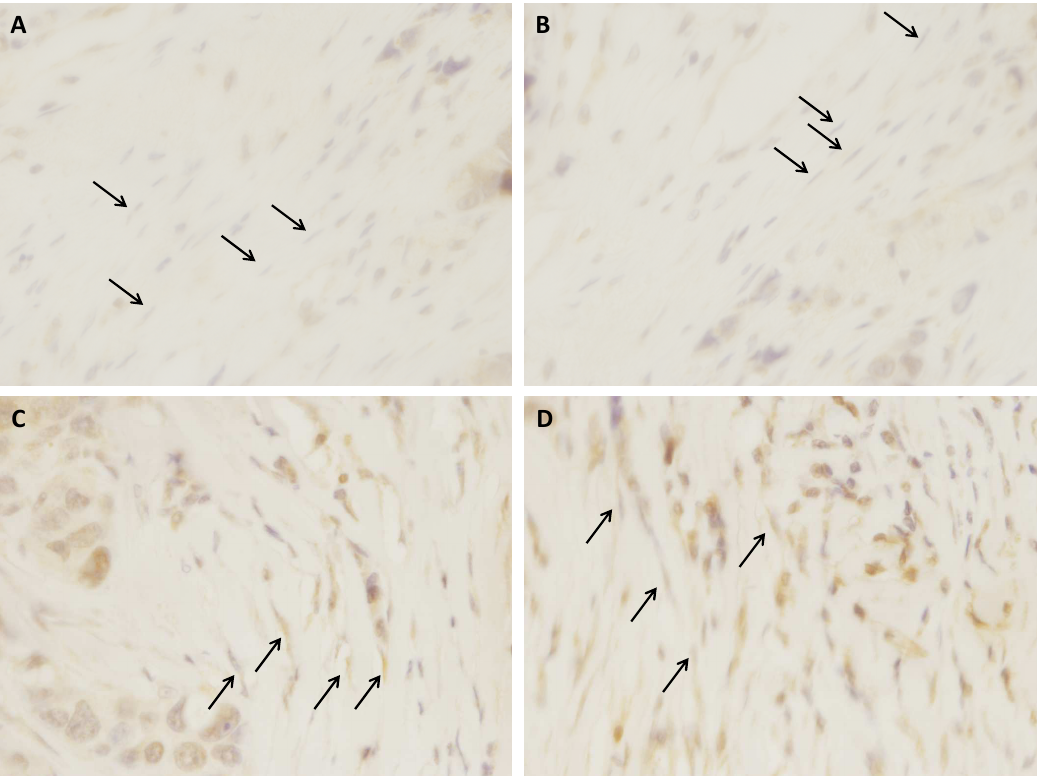
Figure 5. Representative examples of IGF2 ( A , B ) negative and ( C , D ) positive immunostaining in fibroblasts, corresponding to ( A , B ) a non-metastatic and ( C , D ) a metastatic luminal B breast cancer, respectively ( × 400). Black arrows represent